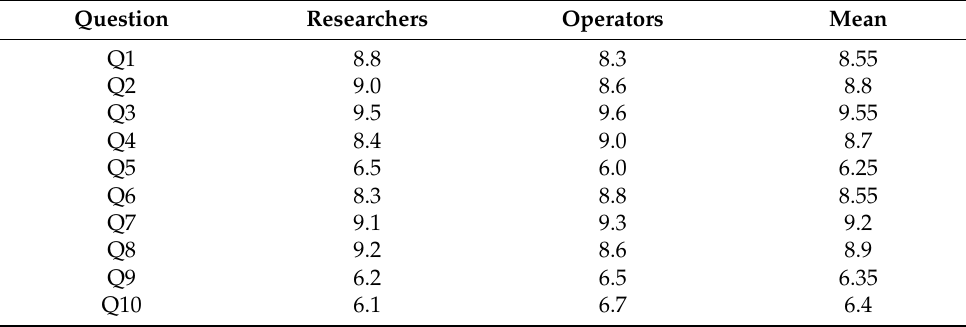
Table 5. The user evaluation results of the QDARV development